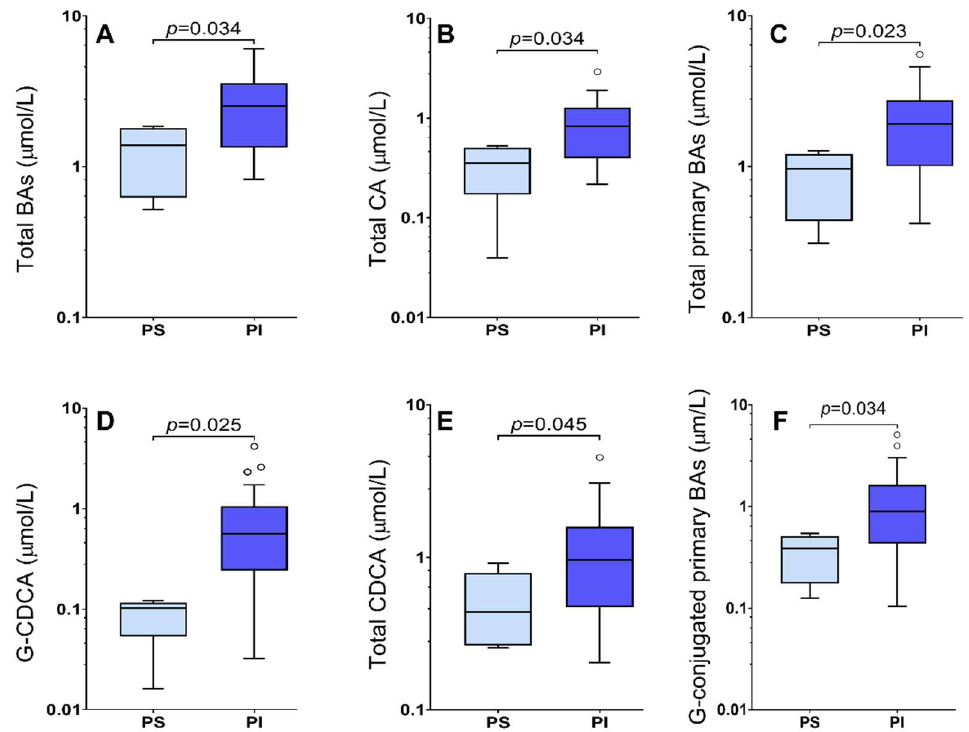
Figure 5. Bile acid concentrations from pwCF classified according to their pancreatic sufficiency status: pancreatic sufficiency (PS) or pancreatic insufficiency (PI). ( A ) Total bile acids. ( B ) Total CA, i.e., CA+T-CA+G-CA. ( C ) Total primary BAs, i.e., CA+T-CA+G-CA+